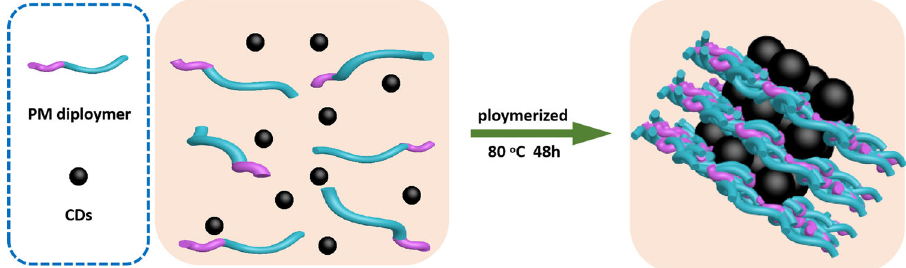
Fig. 1 Synthesis process. The synthesis process of organic polymer composite systems. PM dipolymer represents procyanidins-methoxybenzaldehyde